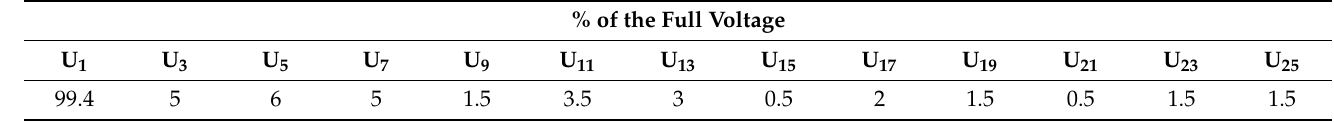
Table 2. Relative magnitudes of harmonics in a signal modeling real voltage signal. % of the Full